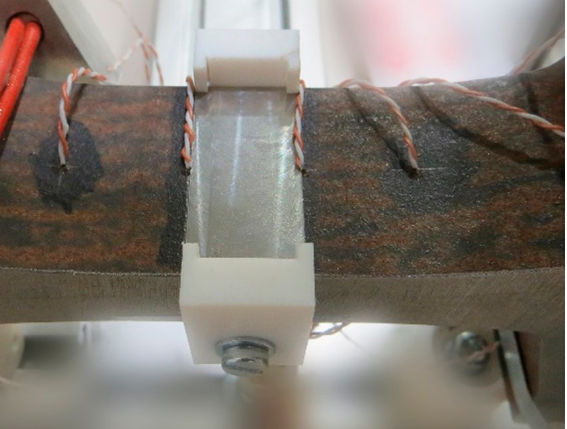
Figure A3. Milled rail surface as the contact surface and adjacent measurement spots of the thermo- couples.